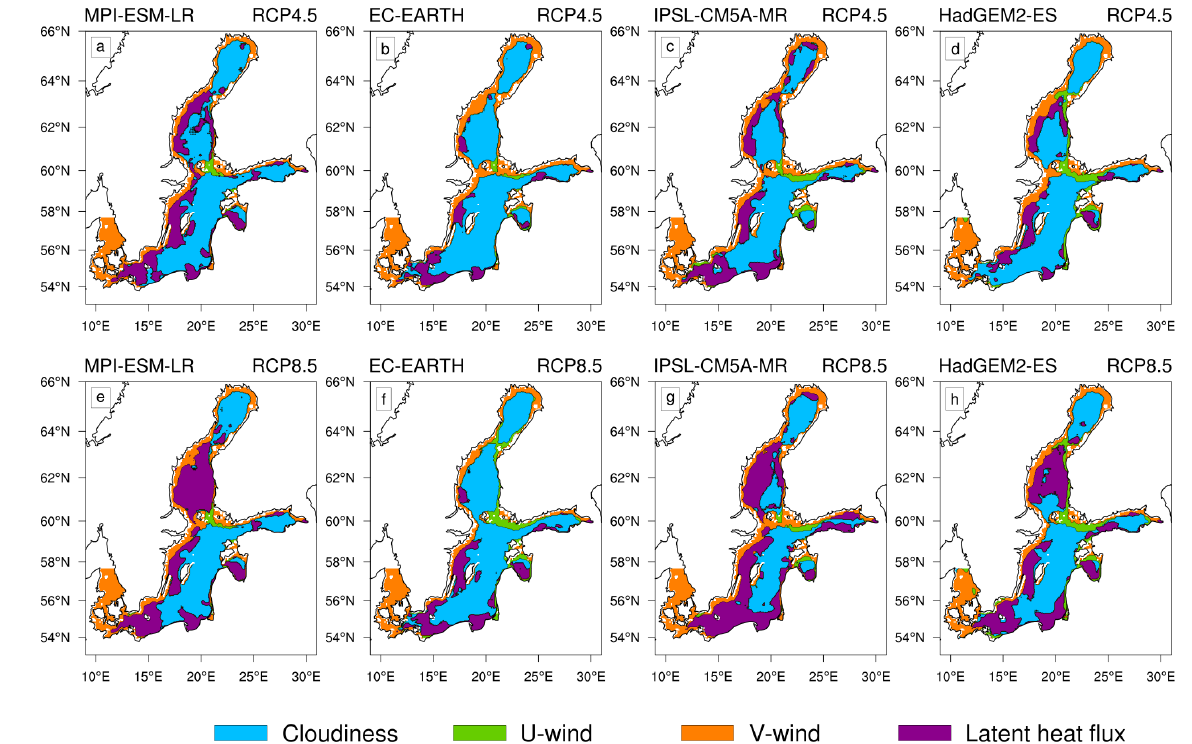
Figure 16. Results of the cross-correlation analysis of the detrended SST (monthly mean) with the wind components, latent heat flux and cloudiness. Maps of the atmospheric drivers with the highest cross-correlations in the RCP4.5 (a–d) and RCP8.5 (e–h) scenarios for various GCM forcings (Saraiva et al., 2019a). From left to right: MPI-ESM-LR, EC-EARTH, IPSL-CM5A-MR, HadGEM2-ES.